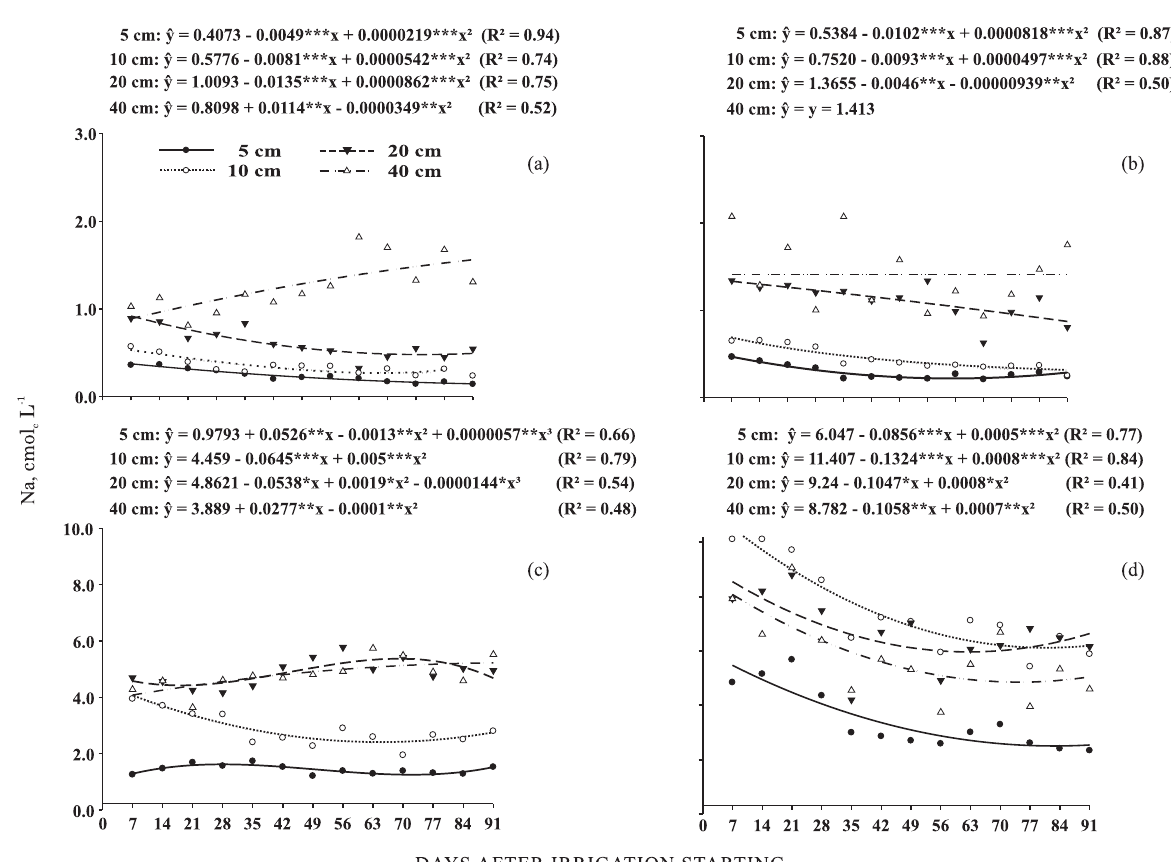
Figure 1. Sodium concentration in the soil solution at different depths and salinity levels: Casamento (a)